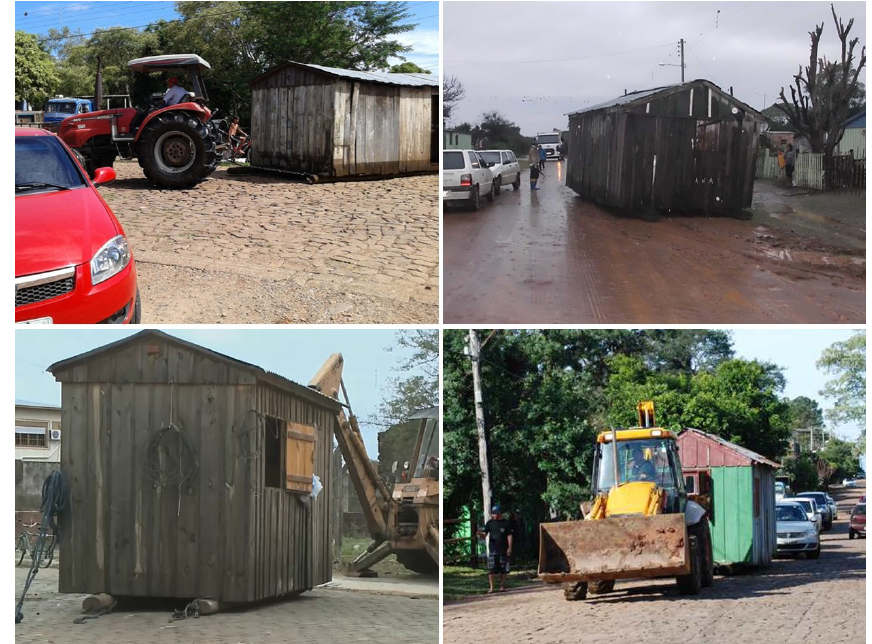
Figure 2. “Volantes houses” being transferred in periods of flooding in Itaqui.